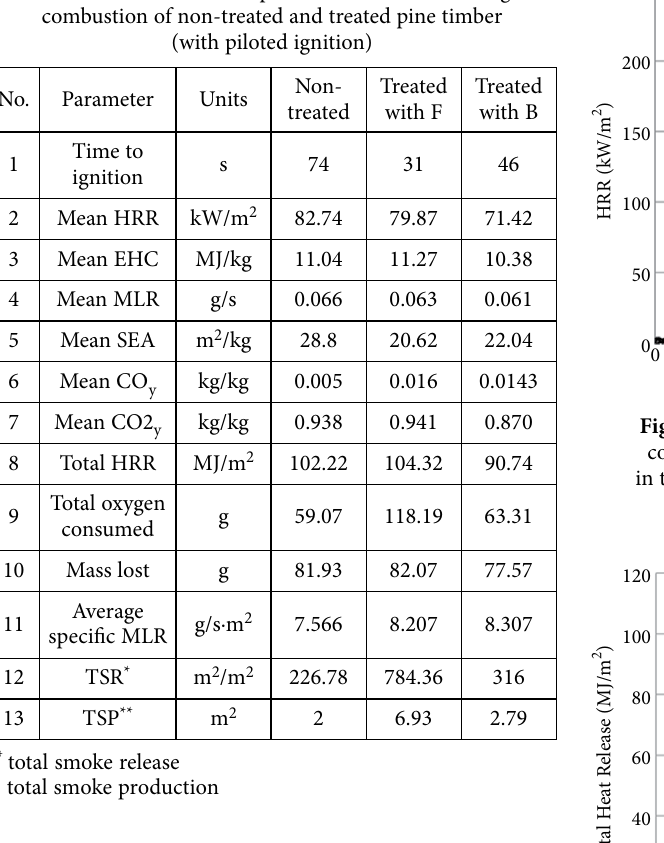
Table 4. Some characteristic parameters obtained during the combustion of non-treated and treated pine timber (without piloted ignition)